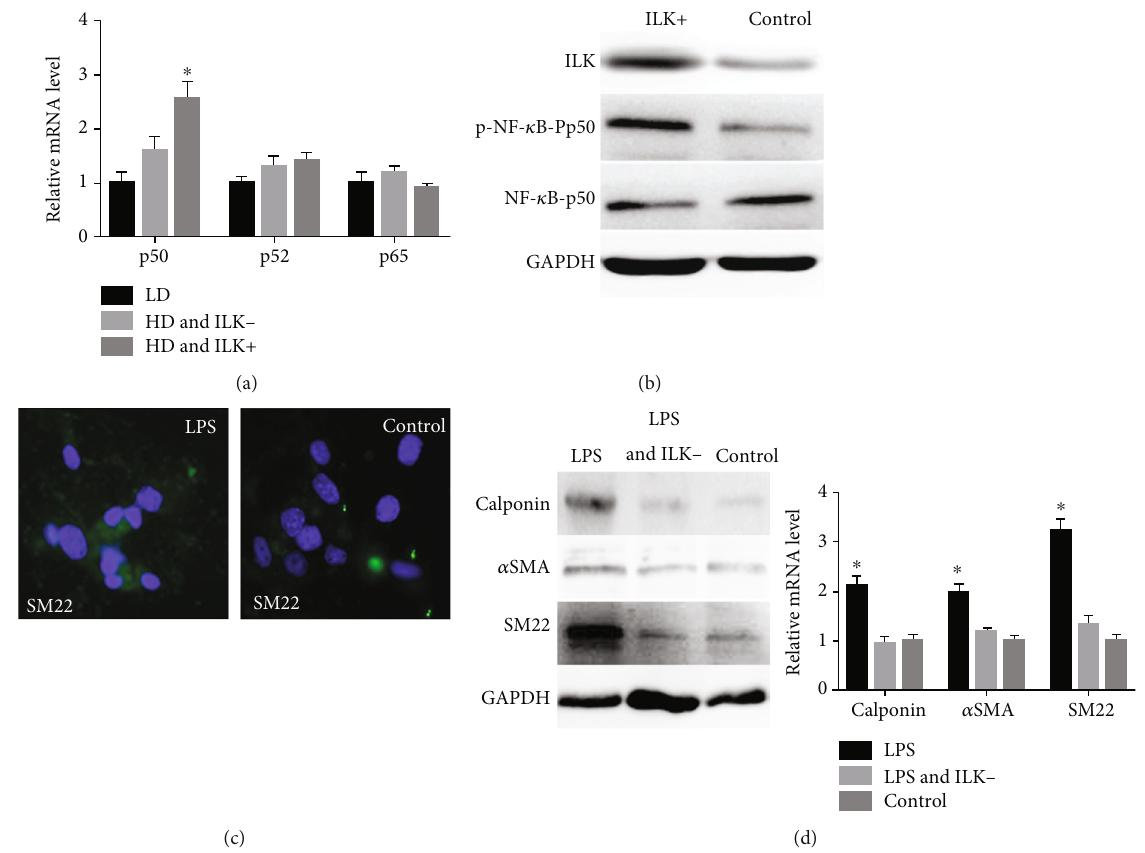
Figure 4: (a – d) The NF- κ B signaling pathway involved in the ILK stimulated di ff erentiation of USCs to SMCs. qRT-PCR detected the mRNA expression levels of NF- κ B p50, NF- κ B p52, and NF- κ B p65 in low density (LD) and high density (HD) (a). Protein levels of ILK, p-NF- κ B p65, and NF- κ B p65 in USCs with LPTP (ILK+) and control USCs were detected using Western blot analysis (b). Lipopolysaccharide (LPS), a component of Gram-negative bacteria, which is used to activate the NF- κ B pathway of USCs, immunostaining for SM22 in USCs with LPS and control USCs (c). The expression of SMC-speci fi c markers (calponin, aSMA, SM22) in USCs with the e ff ects of NF- κ B activator LPS, LPS, and knocking down ILK (ILK-), or nothing, were detected by Western blot and qRT-PCR